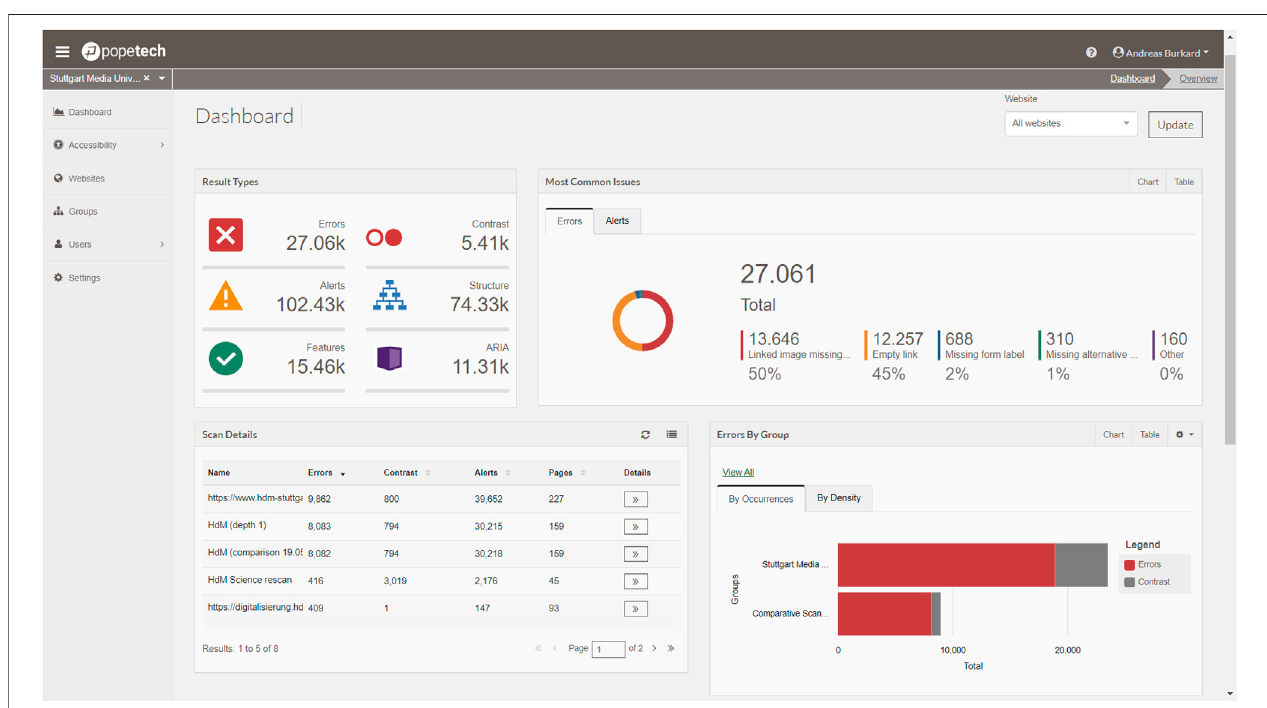
FIGURE 2 | Pope Tech dashboard.